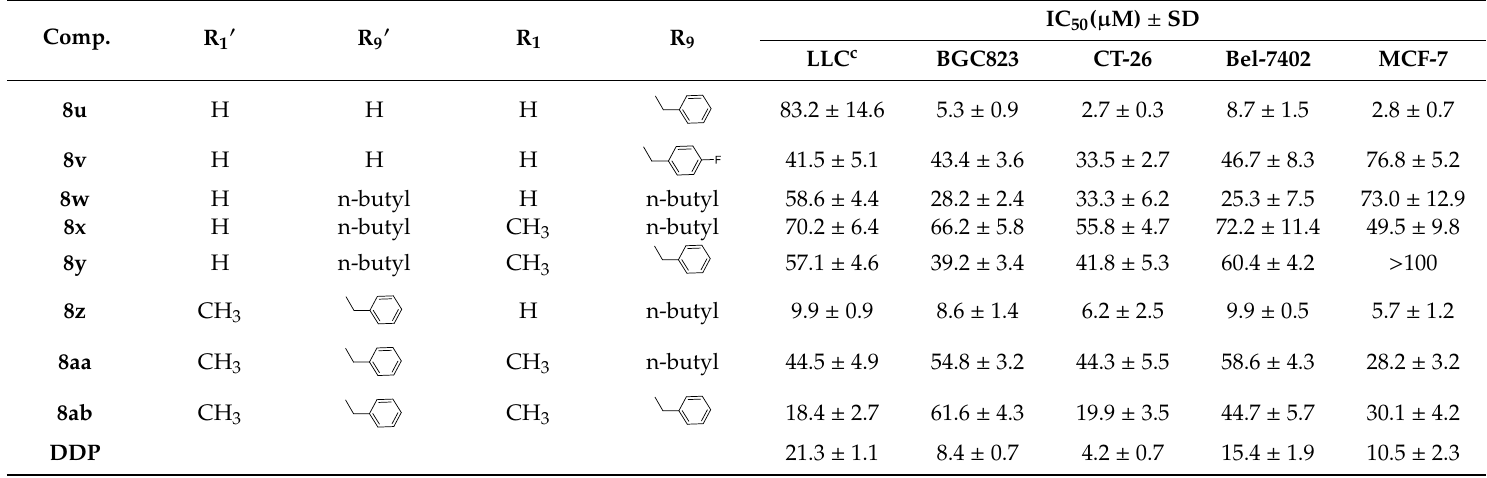
a Data represent the mean values of three independent determinations; b cytotoxicity as IC 50 for each cell line is the concentration of compound which reduced the optical density of treated cells by 50% with respect to untreated cells using the MTT assay. The data represent the mean values ± SD of at least three independent determinations. Values > 100 μM indicate less than 50% growth inhibition